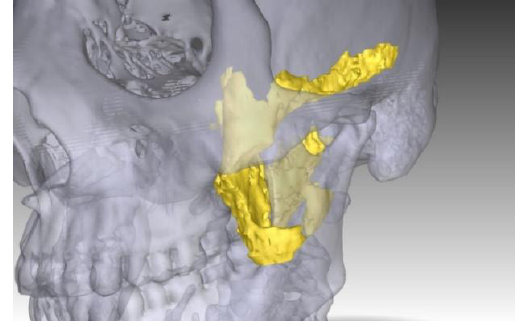
Figure 2. Reconstruction of the buccal fat pad. The connection between the buccal process and temporalis process is